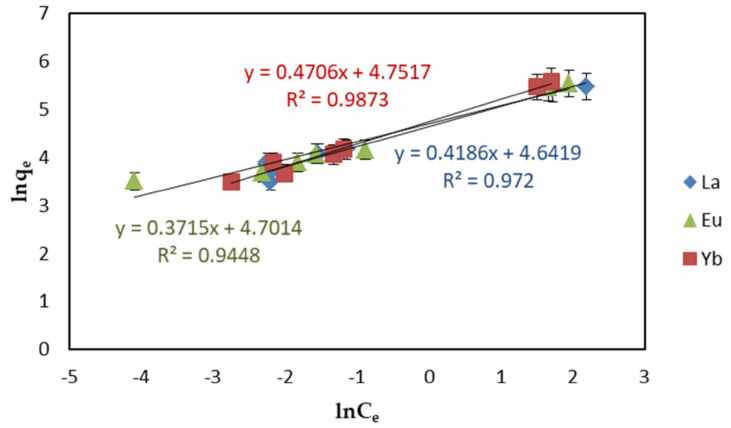
Figure 12. Freundlich isotherms of REEs adsorption on EDTA–CS@ZIF-8.